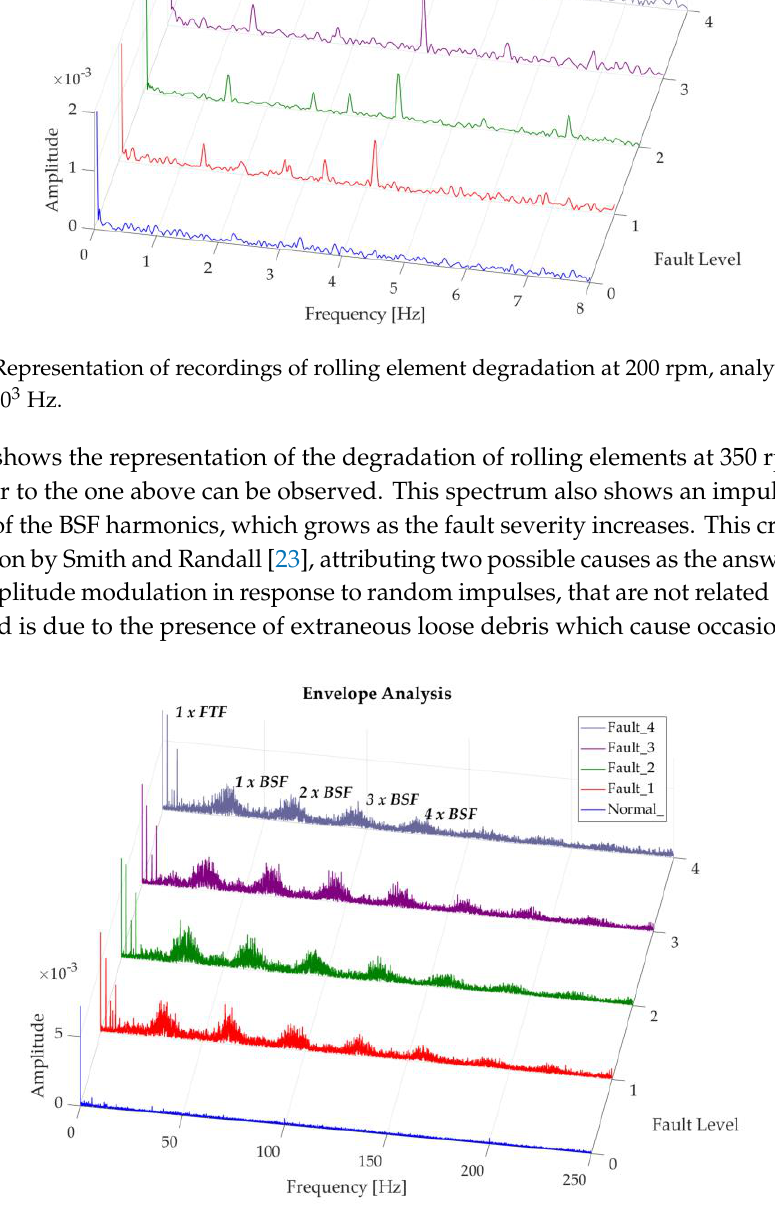
Figure 17. Representation of the Envelope of recordings of the rolling element degradation at 350 rpm, in a band of 1.8 × 10 3 to 6.1 × 10 3 Hz.